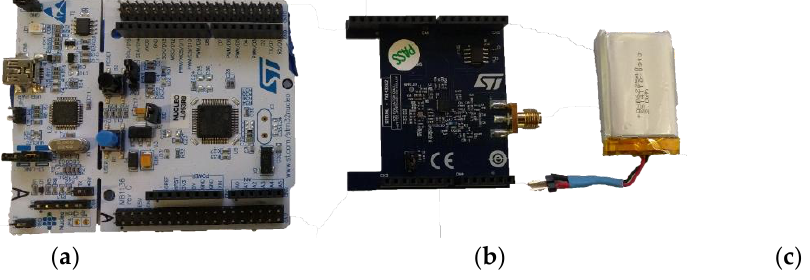
Figure 3. ( a ) Mother board: Nucleo STM32L053R8, ( b ) daughter board with ST S2-LP sub-GHz radio, ( c ) 3.6 V battery.